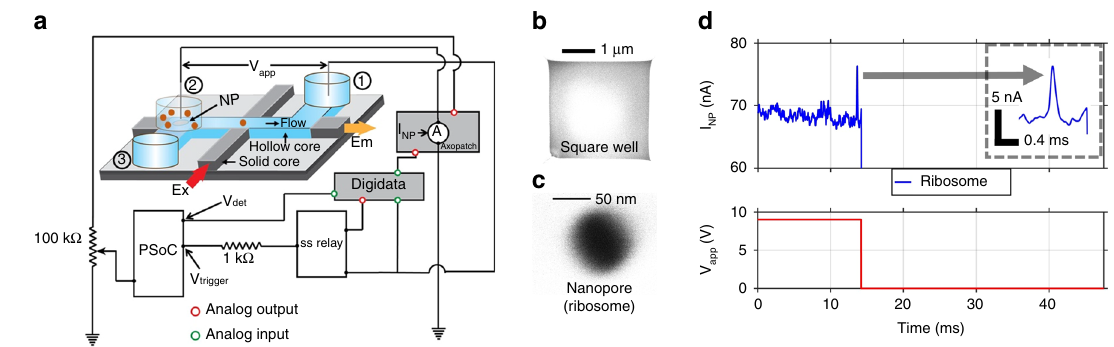
Fig. 1 On-demand single molecule analysis platform. a A nanopore-opto fl uidic chip combines liquid-core (blue) and solid-core (gray) optical waveguides; particles are introduced into the liquid-core waveguide by applying a voltage across reservoirs 1 and 2, where reservoir 2 is placed over a nanopore; fl uorescence is excited via an intersecting solid-core waveguide and collected by the liquid-core waveguide. The chip is connected to an electronic circuit for implementing feedback control over the number of particles entering the channel through the nanopore b SEM image of a typical square well milled on the microchannel to remove the thick oxide layer for further nanopore drilling. c SEM image of a drilled nanopore. d Experimental demonstration of voltage- gated delivery of a single 70 S ribosome into the micro fl uidic channel; top: nanopore current (inset: zoomed in translocation), bottom: voltage applied across the nanopore